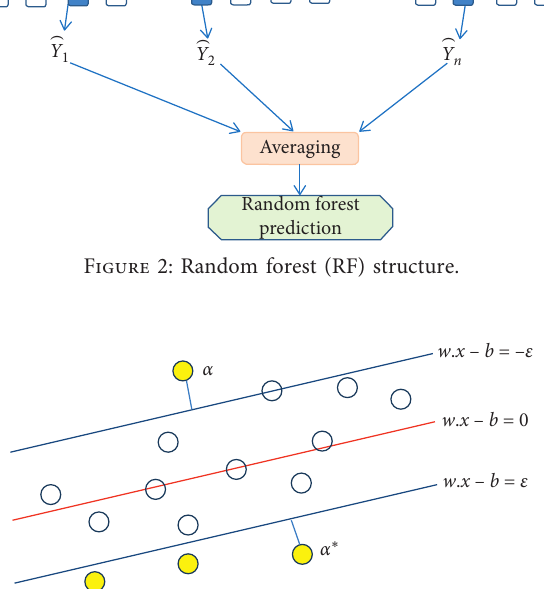
Figure 3: Support vector machine for a regression problem.